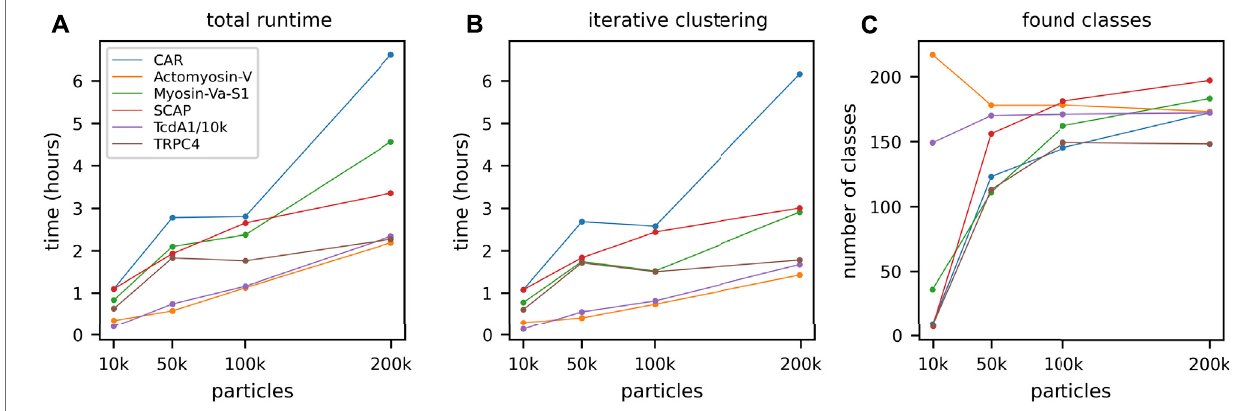
FIGURE 3 | GPU ISAC runtime variance when processing different data sets. To demonstrate the runtime variance across data sets, we processed six different data sets of varying quality and clustering dif fi culty: Cell adhesion receptor (CAR) (blue) , actomyosin-V (orange) , myosin (green) , SCAP (red) , TcdA1 (purple) , and TRPC4 (brown) . For each data set we processed subsets containing 10,000, 50,000, 100,000, and 200,000 particles, respectively. (A) While the runtime of the CUDA kernelsscalesstrictlylinearly( SupplementaryFigureS1 ),full-scaleGPUISACrunsdisplayahigheramountofvarianceintheirscalingacrossdatasets.However, it can be seen that the runtime still approximates linear scaling rather than exhibiting quadratic (or worse) scaling behavior. (B) The scaling behavior shown for the total runtimeismirroredinthepureprocessingpartsofGPUISAC(iterativeclustering).Forupto200kparticlesGPUISACisnotIOlimitedandspendsthemajorityofitstimein the actual data processing, rather than data handling. (C) While thenumber ofproduced classes acrossdifferentruns and data sets rises when more datais used thisis not alinear trend. While the defaultparametersimpose an upper limit of 200found classes, it can be seen that this limit is not reached in all cases and simply using more particles does not necessarily yield signi fi cantly more